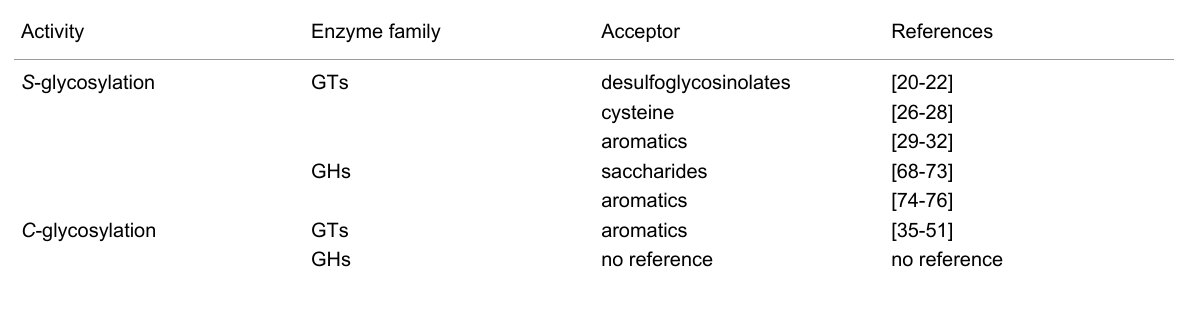
Table 1: Summary of rare synthetic activities of carbohydrate-related